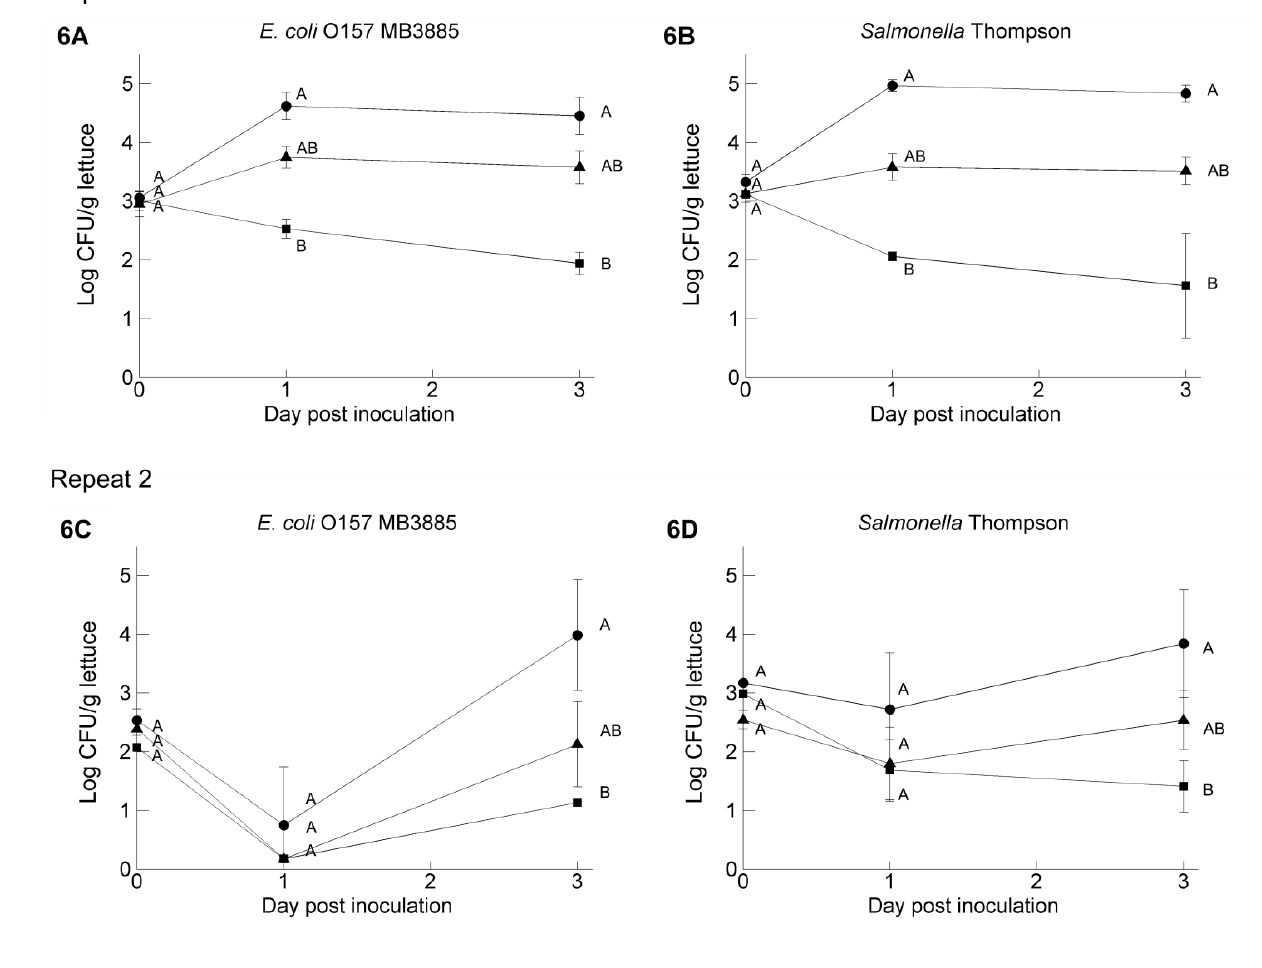
Figure 6. Levels of GFP labeled E. coli O157:H7 MB3885 ( A , C ) and GFP labeled Salmonella Thompson RM1987N ( B , D ) from two independent repeats, recovered from lettuce leaves at three time points after inoculation with the pathogens suspended in phosphate buffer-saline (  ), pond water 2 (  ) or ground water 3 (  ). Data presented are calculated from the log transformed values of the pathogen population size on three leaf samples and expressed per gram of leaf tissue. Error bars indicate standard deviations. At each day, different letters indicate significant difference ( p < 0.05) between means of pathogen level according to Kruskal-Wallis non-parametric